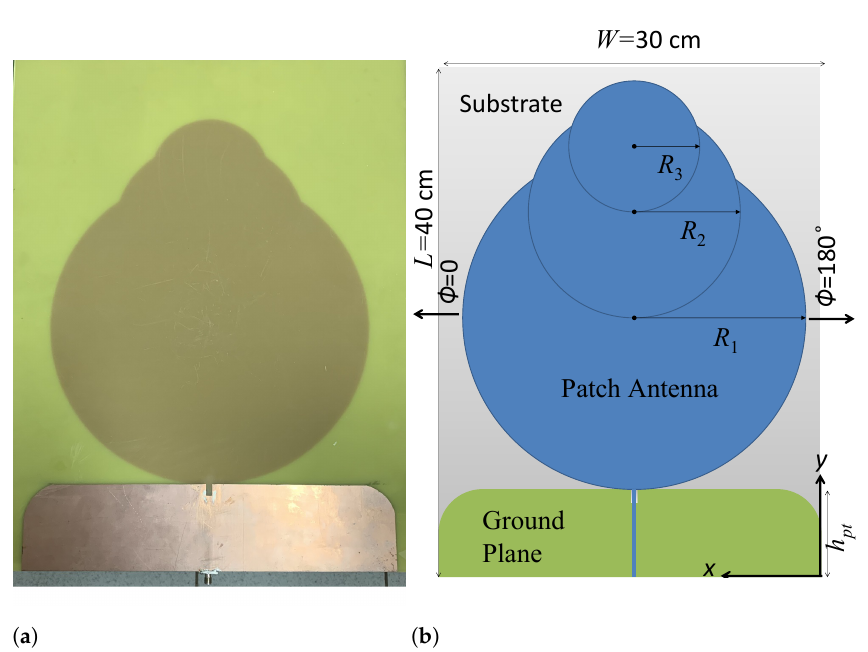
Figure A4. The final antenna, with rounded ground plane: ( a ) manufactured and ( b ) final geometric design.